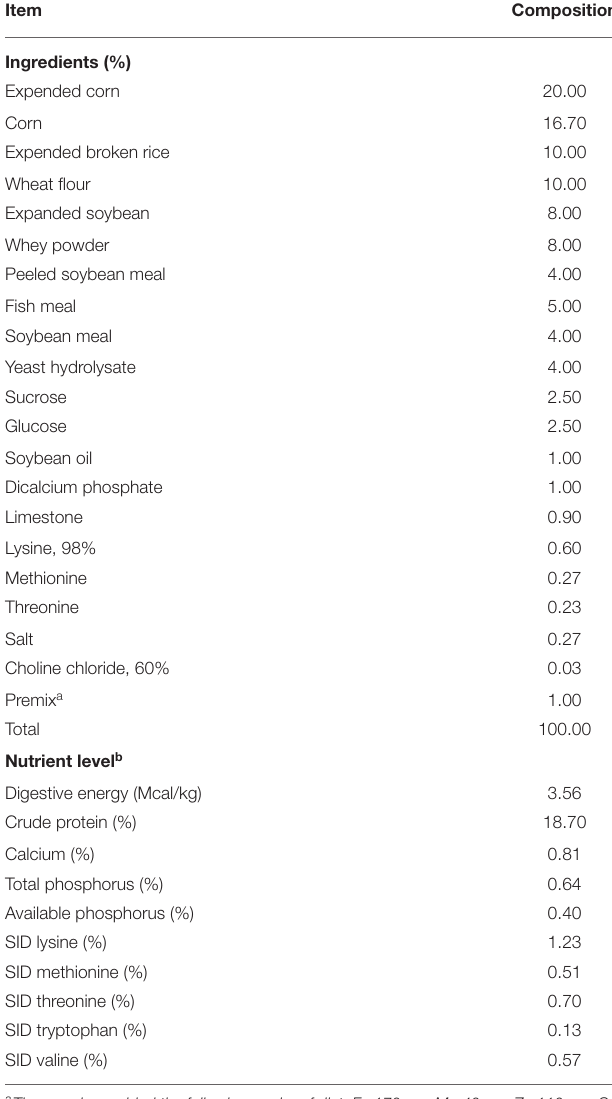
TABLE 1 | The ingredient composition and nutrient level of the basal diet (as-fed